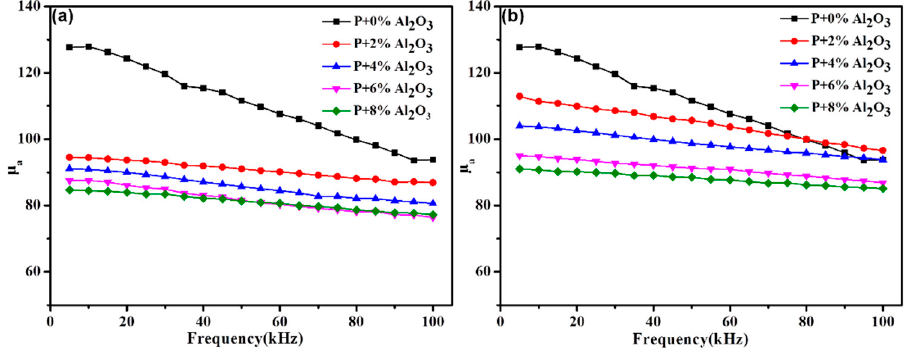
Figure 8. The amplitude permeability of the hybrid-coated samples by ( a ) ball milling and ( b ) sol–gel with the same additional amount of Al 2 O 3 .